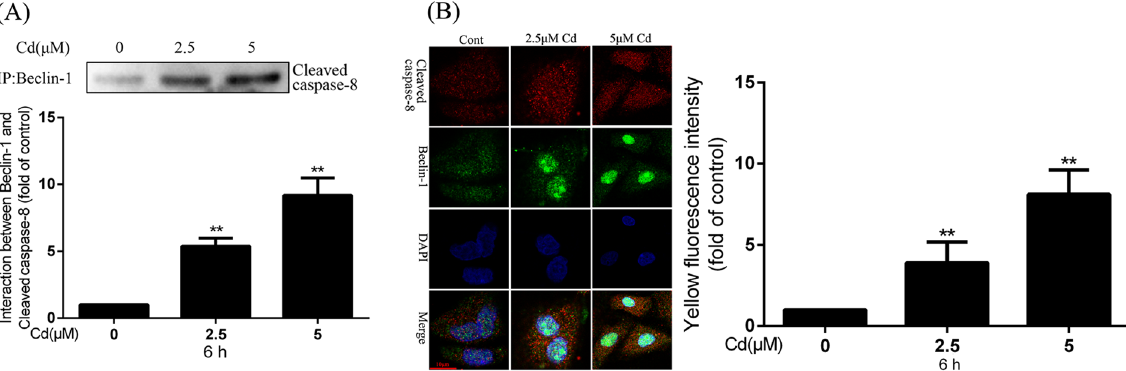
Figure 5. Interaction between Beclin-1 and cleaved caspase-8 after Cd treatment. (A) rPT cells were incubated with 0, 2.5, and 5 μ M Cd for 6 h and the interaction between Beclin-1 and cleaved caspase-8 was analyzed by co-immunoprecipitation. The quantitative analysis was performed on western blot images of four independent experiments (mean ± SEM, n = 4). (B) Representative confocal images of co-localization of Beclin-1 and cleaved caspase-8; yellow fluorescence represent co-localization and the quantitative analysis performed with images of three independent experiments (mean ± SEM, n = 3). ** P < 0.01.